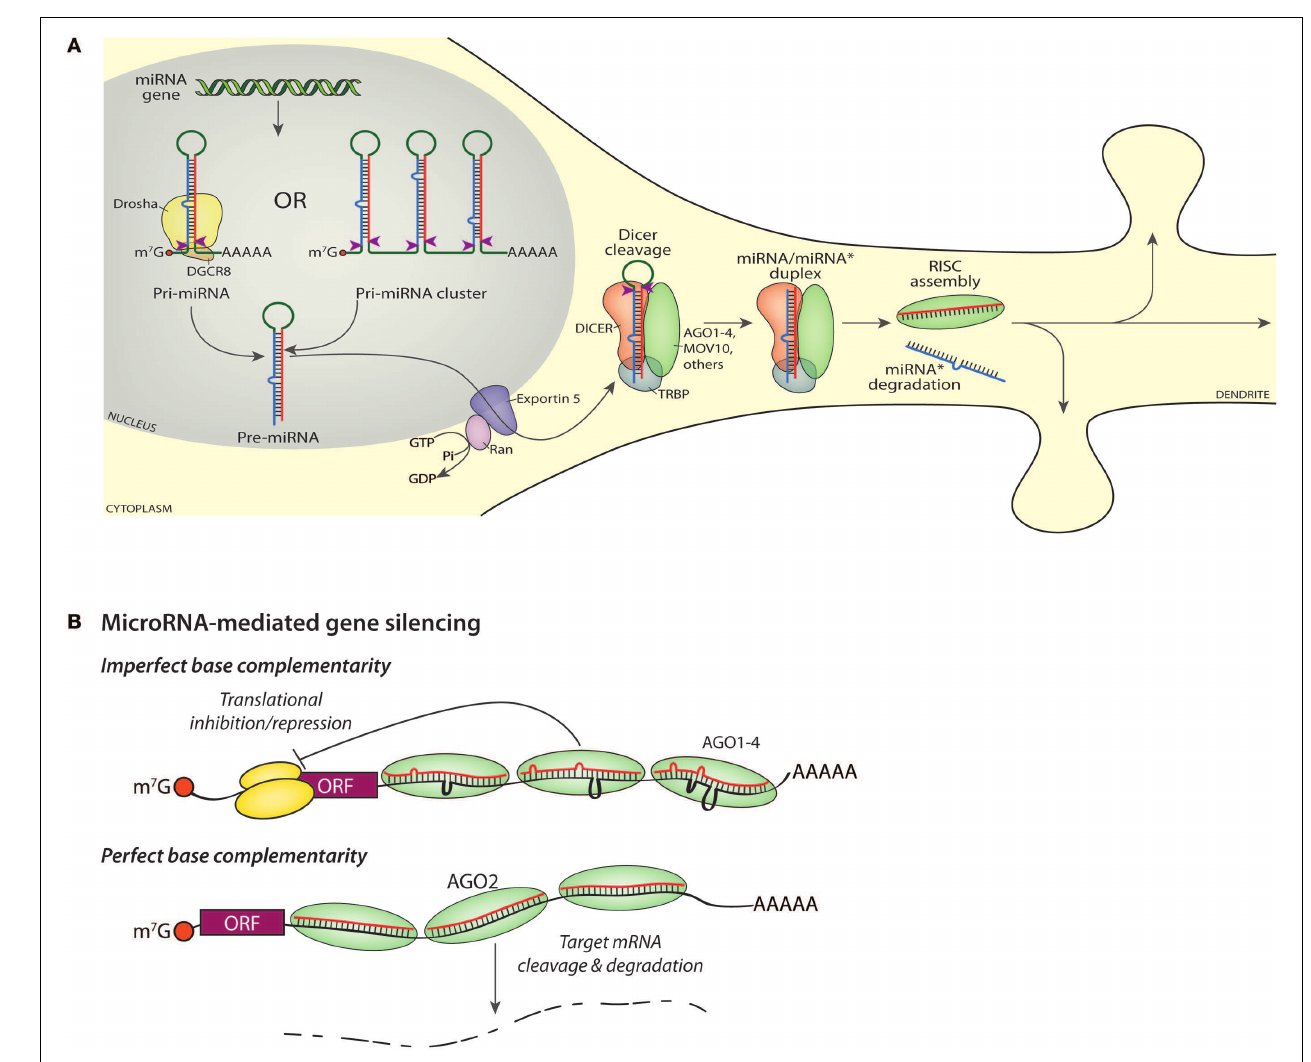
FMR1, DDX9, PUM2 (Schratt, 2009b; Czech and Hannon, 2011; De and MacRae, 2011).The star strand is lost from the final RISC and ultimately degraded, while the assembled RISC is available to bind to cognate RNAs and modulate protein expression. (B) Imperfect base complementarity. When the sequence of the miRNA guide strand does not perfectly match the target mRNA, translation of that mRNA is inhibited. Bound RISCs may contain any one of the four Argonaute proteins.The orange ball is the cap-binding complex; the large and small ribosomal subunits are shown in yellow. Perfect base complementarity. When the sequence of the miRNA guide strand matches the target mRNA perfectly, the target mRNA is sliced by